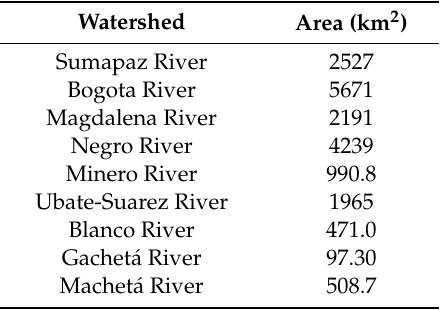
Table 1. Watersheds of the study